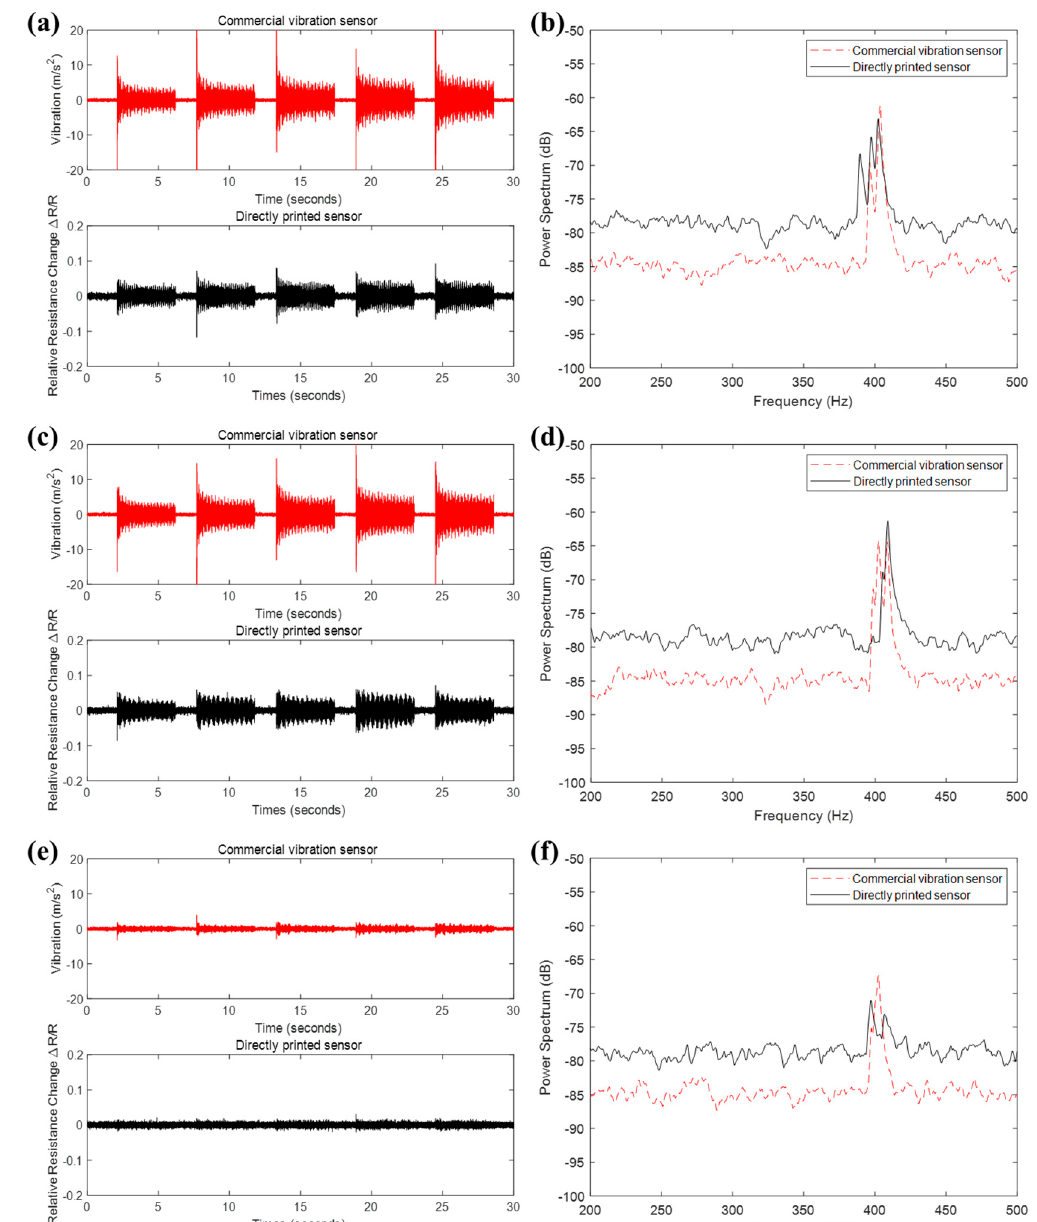
Figure 7. Comparison of experimental results of a commercial vibration sensor and directly printed sensor. ( a , b ) x-axis ( c , d ) y-axis, and ( e , f ) z-axis relative resistance change and power spectrum, respectively.